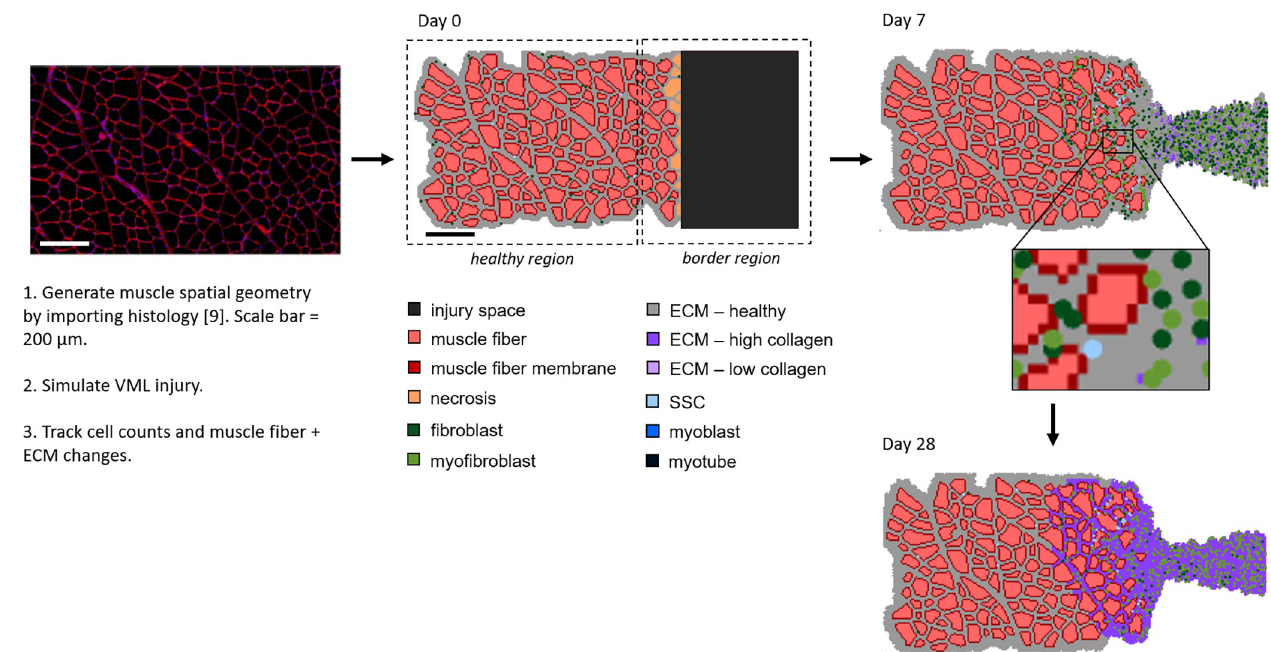
Fig 2. ABM simulates muscle regeneration for 28 days following VML injury. The spatial geometry of the ABM was defined by importing a histological image [9]. Then a VML injury was simulated by removing 12 fibers and creating an injury space, and replacing severed fibers at the edge of the injury and native muscle with necrotic elements. The ABM consisted of two regions–the healthy region of muscle fibers near the injury that were not affected by the defect and the border region consisted of fibers near the injury and the injury space. Regeneration was followed over time by tracking cell counts, muscle fiber counts, and collagen density in each